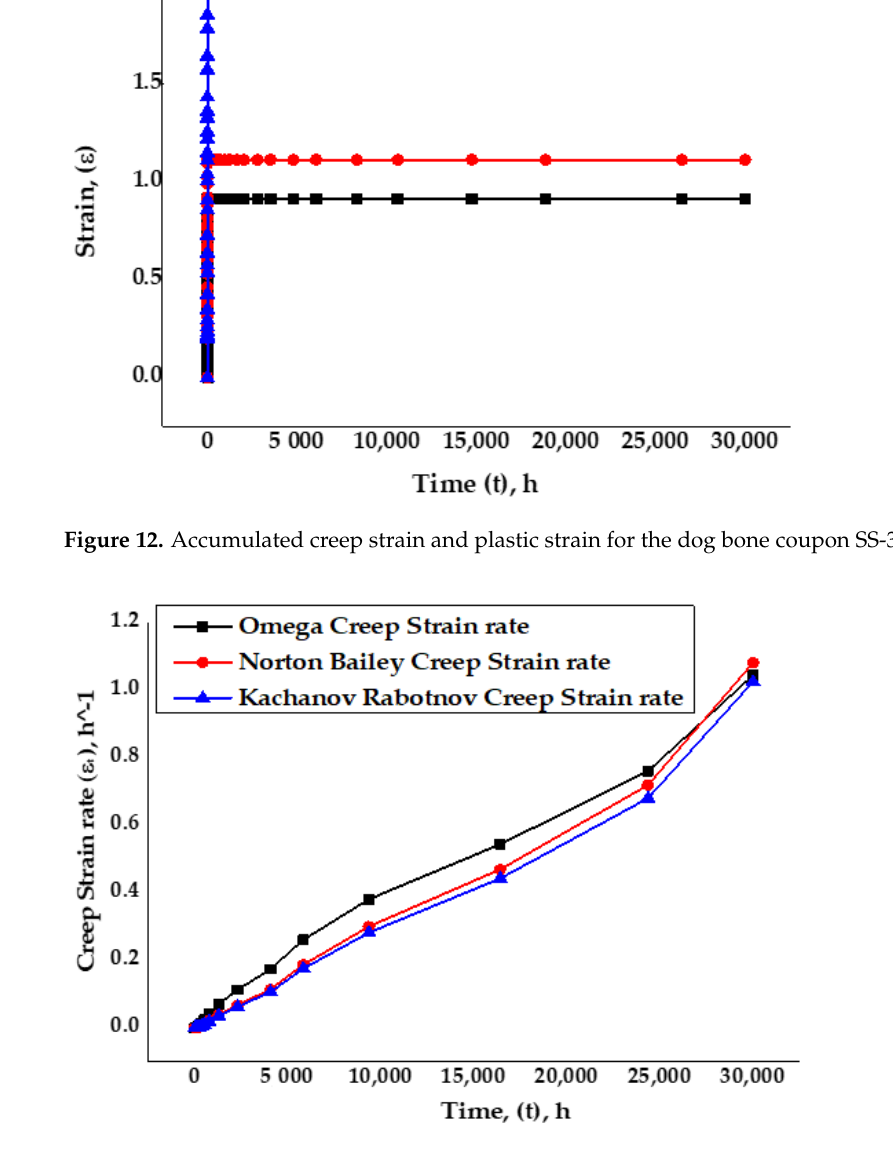
Figure 12. Accumulated creep strain and plastic strain for the dog bone coupon SS-316.